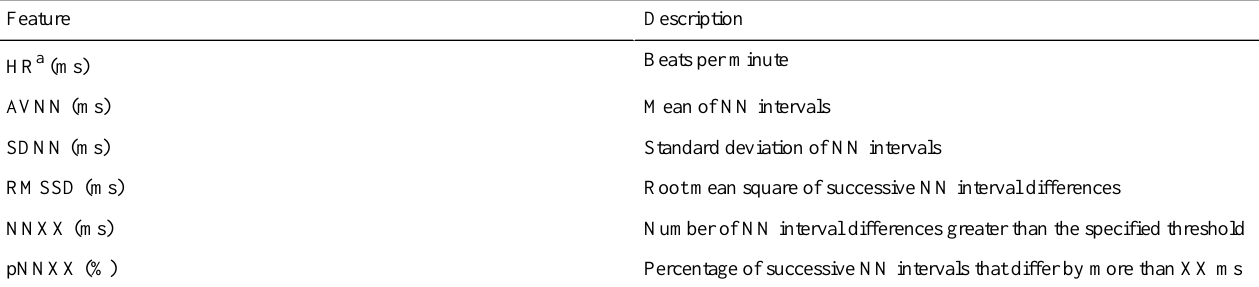
Table 1. Time domain heart rate variability features and their definitions. DescriptionFeature